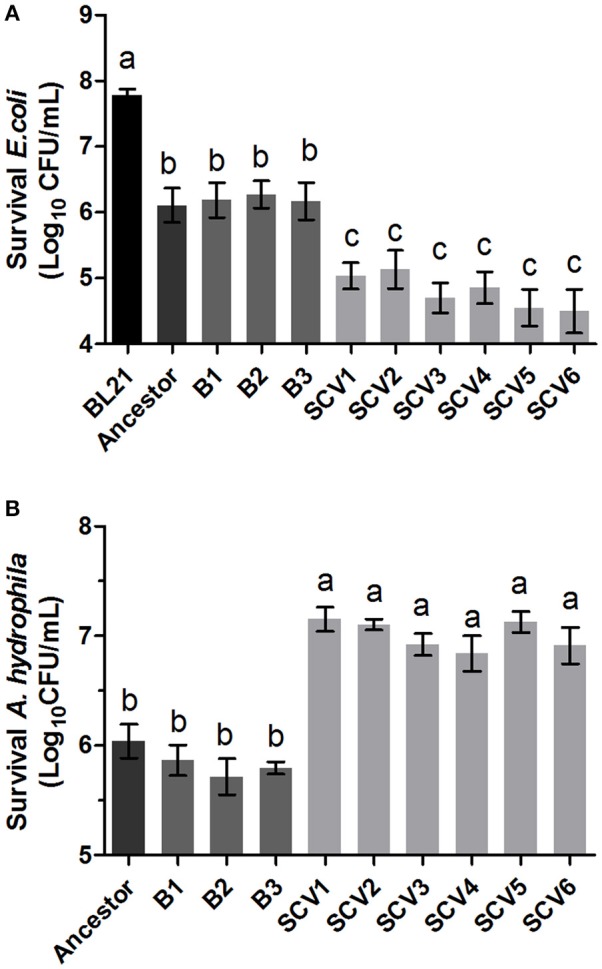
Competition ability and H2O2 resistance levels of the ancestor, B strains (non-Tetrahymena-exposed) and SCV strains (Tetrahymena-exposed). (A) The competition capability of A. hydrophila strains against E. coli BL21 was defined as the amount of survival E. coli after antagonism. (B) The H2O2 resistance levels of the ancestor, B strains and SCV strains were expressed as the CFU of the viable A. hydrophila after treatment with H2O2. Data are presented as the mean ± SD of three independent experiments, with each experiment being comprised of four individual measurements. Different lowercase letters (a, b, c) indicate significant differences (P < 0.05) among different bacterial strains.